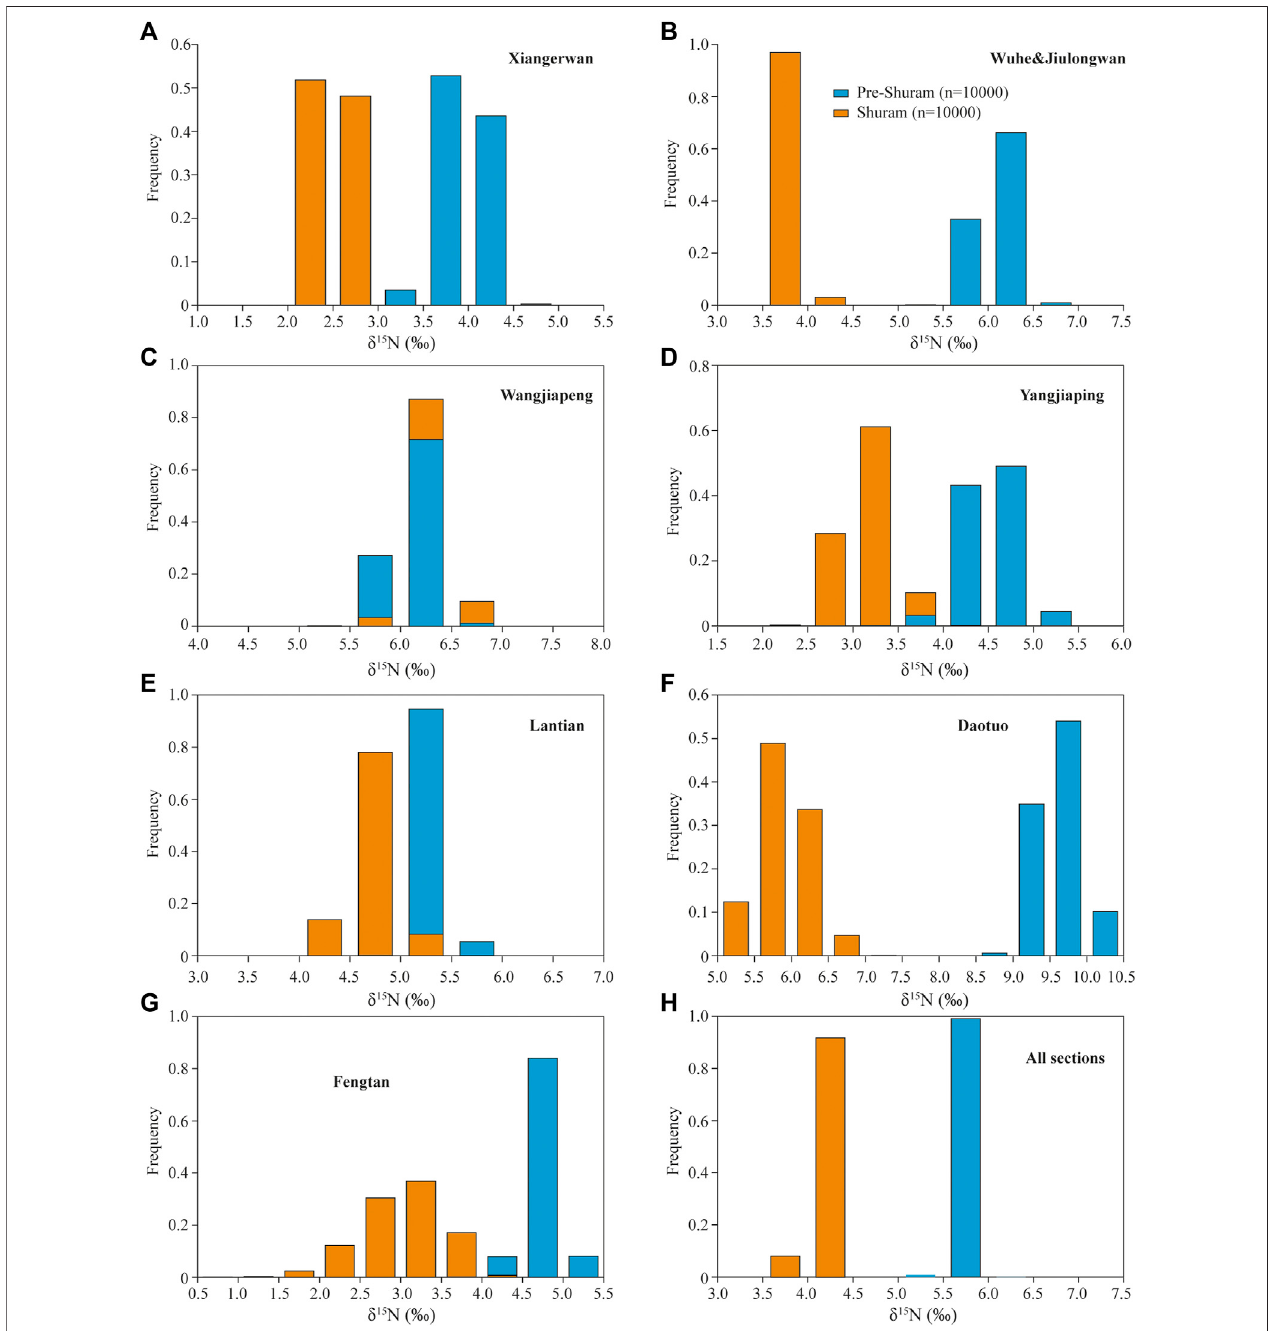
FIGURE 7 | Bootstrap distribution of δ 15 N before and during the Shuram-EN3 excursion in the Xiangerean section (A) , Jiulongwan section (B) , Wangjiapeng drill core (C) , Yangjiaping section (D) , Lantian drill core (E) , Daotuo drill core (F) , Fengtan section (G) , and all sections (H) .